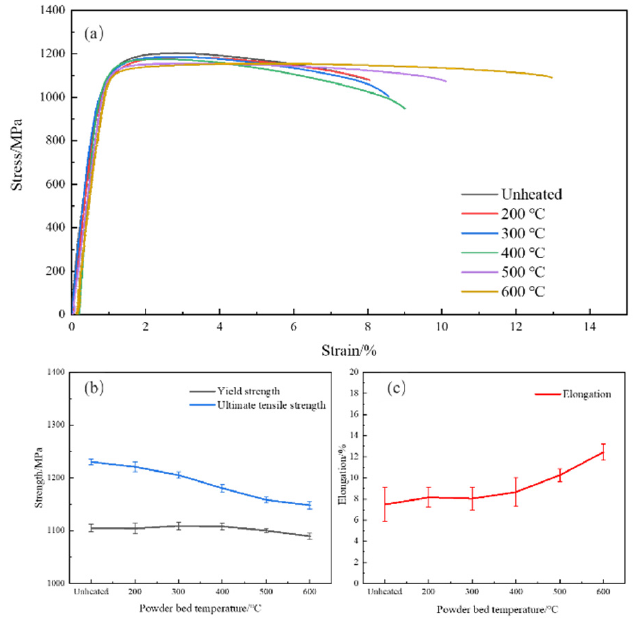
Figure 9. ( a ) Engineering stress-strain curves, ( b ) strengths, and ( c ) elongation of the Ti-6Al-4V alloy after LPBF at different powder bed temperatures.